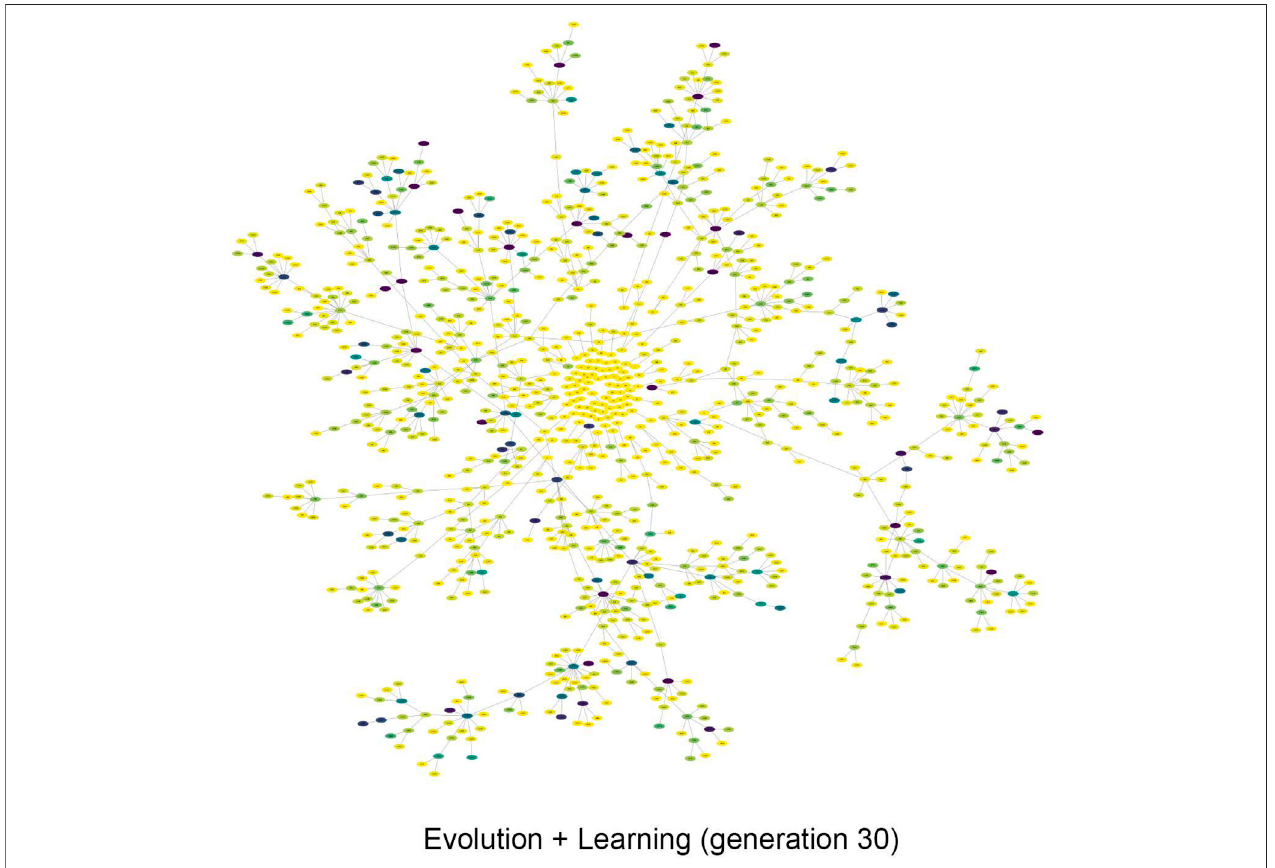
FIGURE 9 | The genealogical tree of Evolution + Learning at generation 30. The descendants are spread out evenly across generations, as are the individuals with the highest fi tness. It also demonstrates that descendants with high fi tness can originate from ancestors with lower fi tness (i.e., lighter nodes), rather than concentrating themselves in lineages that started with a high fi tness in Evolution-Only as shown in Figures 8 – b ( ‘ fi tness begets fi tness ’ ).